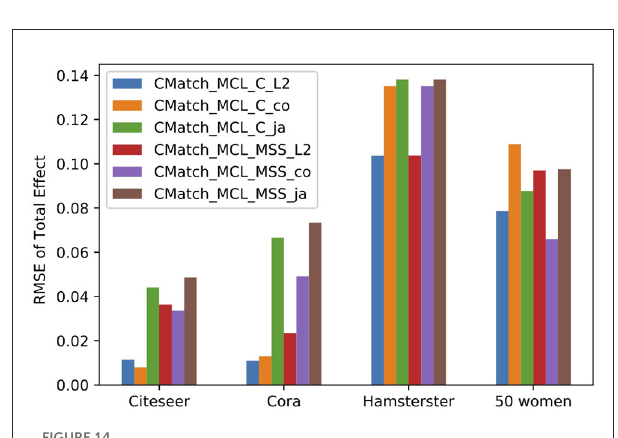
FIGURE14 RMSE of total effect in the presence of contagion using three different similarity methods to calculate spillover probability: Cosine (co), Jaccard (ja) and L2